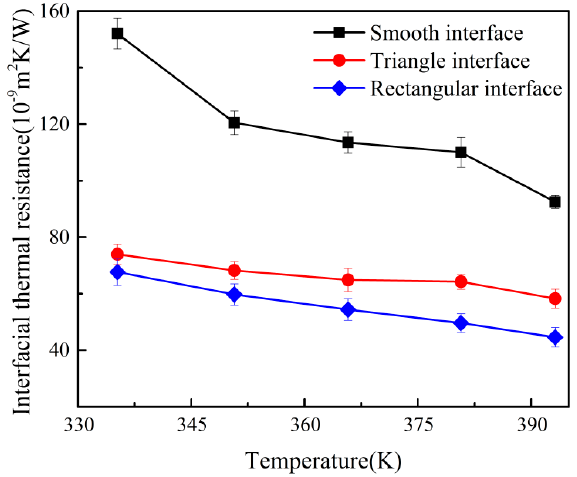
Figure 8. ( a ) The temperature profiles of different interface morphologies; ( b ) rectangular and triangular interface topographies.